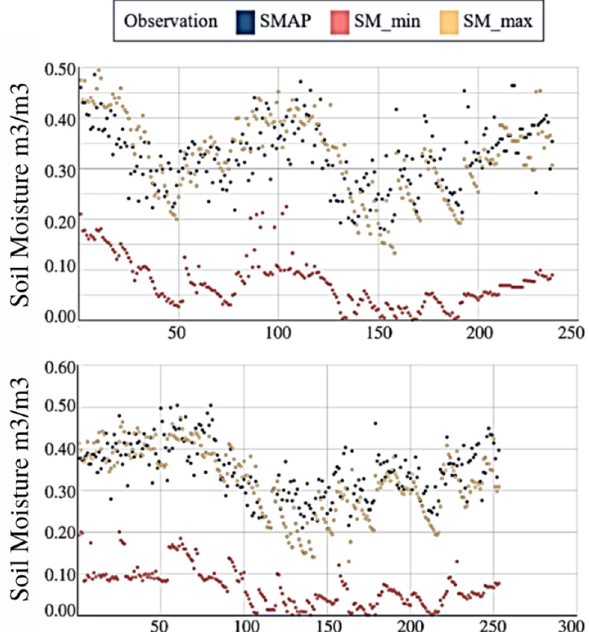
Figure 5. comparison between the range of the measured soil moisture and SMAP L2SMP_E AM Figure 5. Comparison between the range of the measured soil moisture and SMAP L2SMP_E AM overpass ( top ) and PM overpass ( bottom ). overpass ( top ) and PM overpass ( bottom